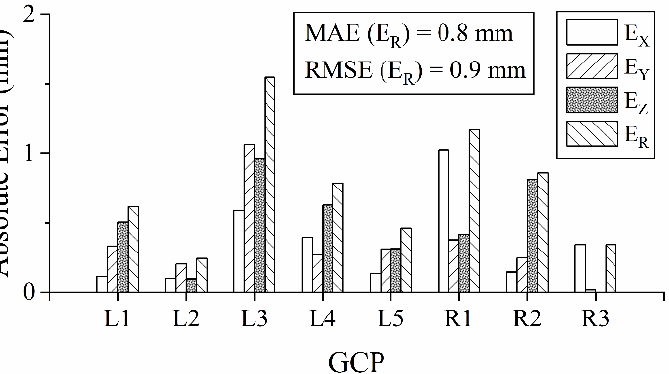
Figure 8. Estimated errors in reproduction of points in a 3D model using SfM, Case Study II. The errors were estimated in model scale. Table 4. Estimated errors in reproduction of selected distances in the 3D model by SfM, Case Study II.